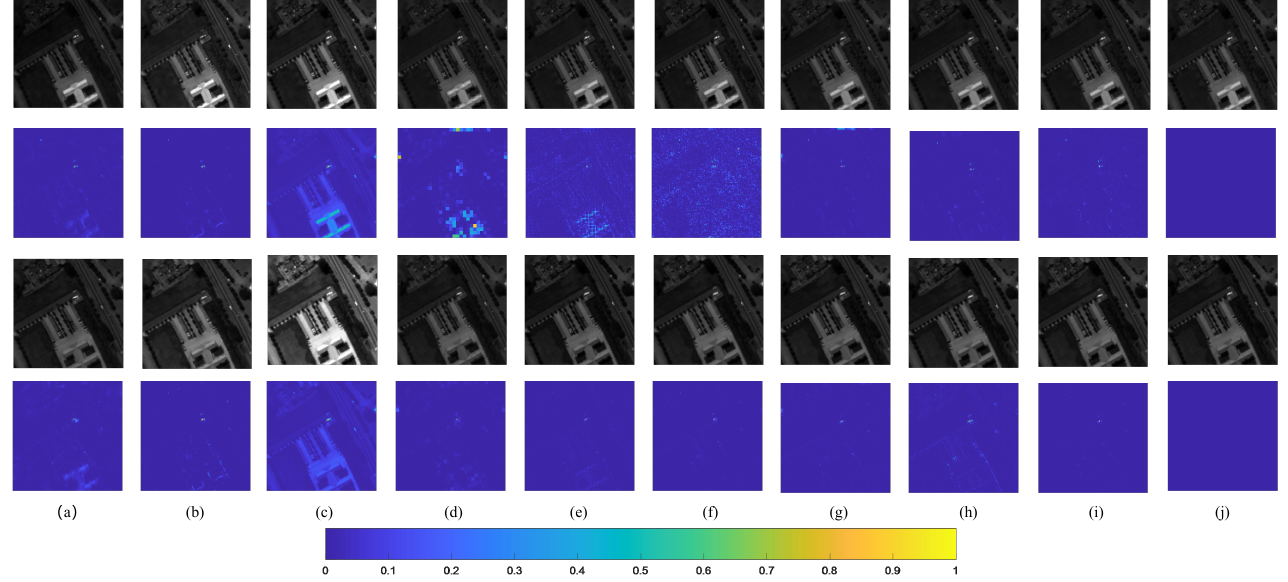
Figure 2. Reconstructed HR-HSI and corresponding error images for Pavia University. First and second rows: reconstructed HSI and its corresponding error image at the 22nd band. Third and fourth rows: reconstructed HSI and its corresponding error image at the 40h band. ( a ) GSA; ( b ) CNMF;